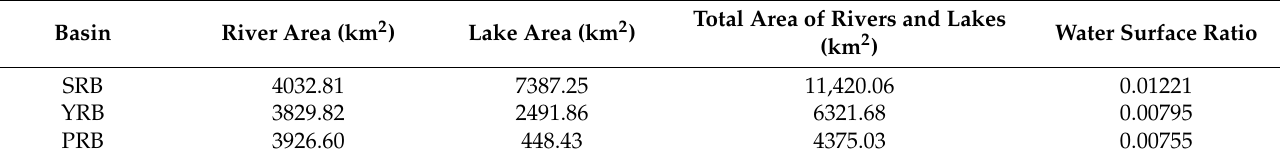
Table 5. River and lake areas and water surface ratios in the three major basins in 2015. Basin River Area (km 2 )